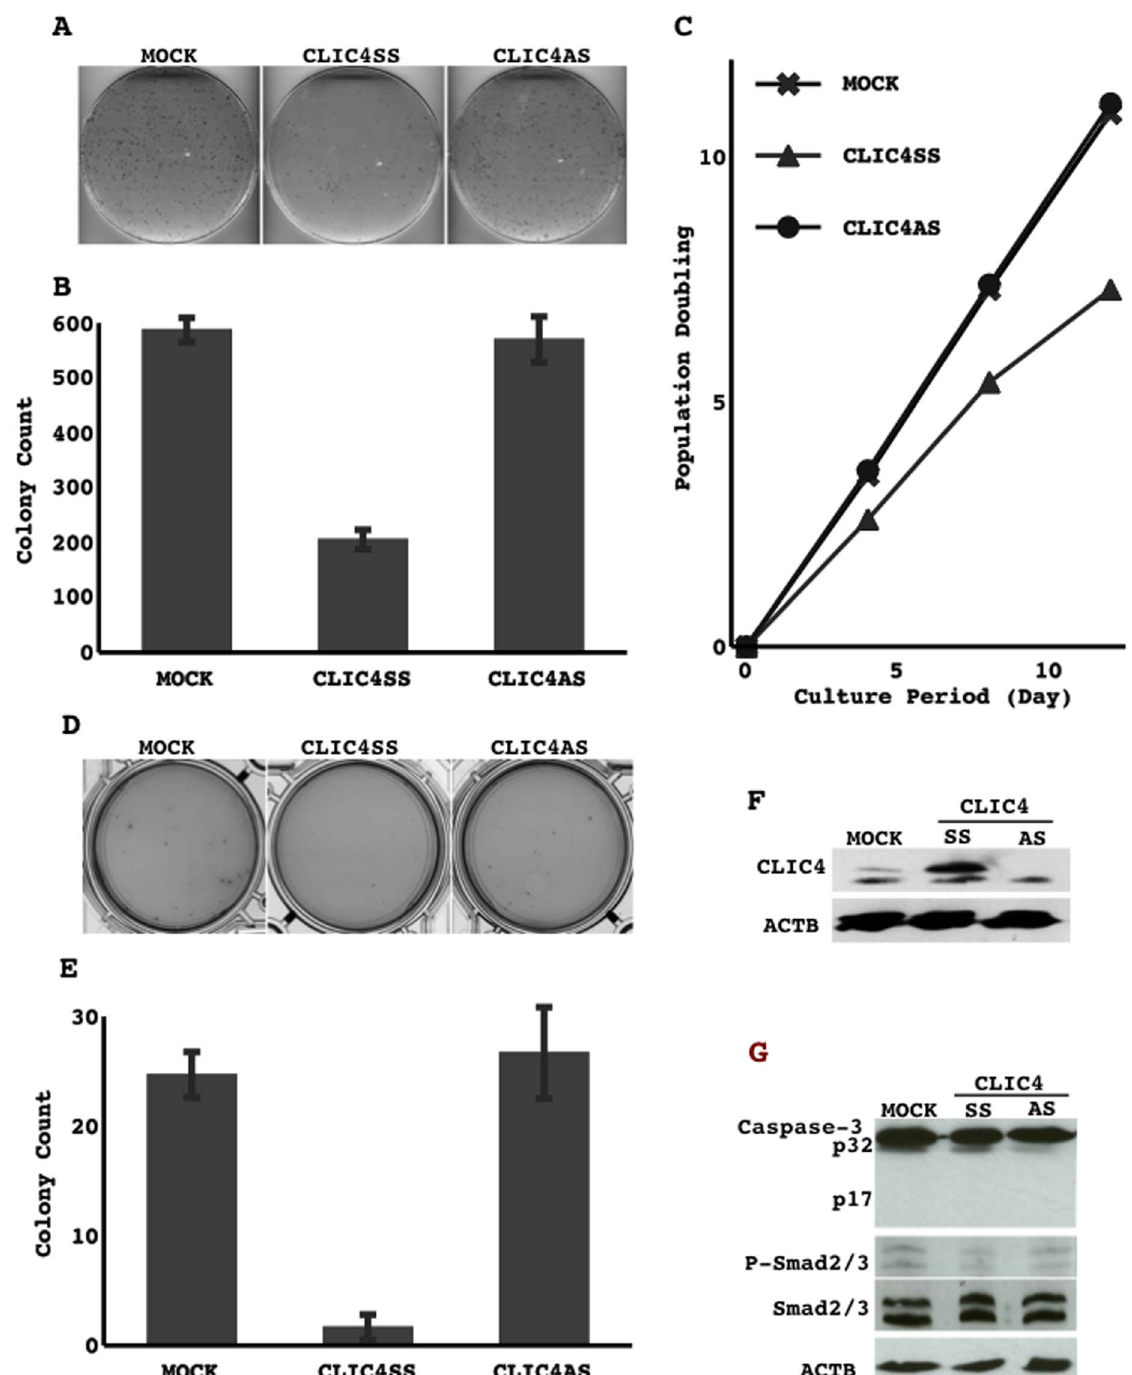
Figure 5. Transduction of empty vector (MOCK), sense strand of CLIC4 (CLIC4SS), and antisense strand of miR-31 (CLIC4AS) were performed. Following a brief selection for 3 days, surviving cells were harvested and counted, and 2.0 6 10 4 cells were reseeded onto a 10-cm dish. Cells were methanol-fixed and Giemsa-stained after 14 days culture (A). The means and standard deviations (error bars) of colony counts from triplicate experiments are presented (B). Cells selected were grown and passed several times. Cumulated population doublings are presented (C). The selected cells (1.25 6 10 4 ) were cultured and grown in 1 ml of DMEM-based 0.3% agar containing 10% FBS in 3.5-cm culture dishes for 4 weeks. The agars were fixed with a buffered 4% paraformaldehyde solution (D). The means and standard deviations (error bars) of colony counts from triplicate experiments are presented (E). Cells harvested immediately after the selection process were examined for the expression of CLIC4, caspase-3, phosphorylated Smad2/3, Smad 2/3, and b -actin (ACTB), by Western blotting (F and G).